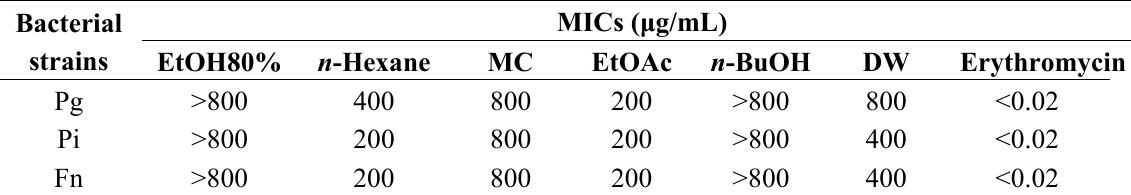
Pg: Porphyromona gingivalis, Pi: Prevotella intermedia, and Fn: Fusobacterium